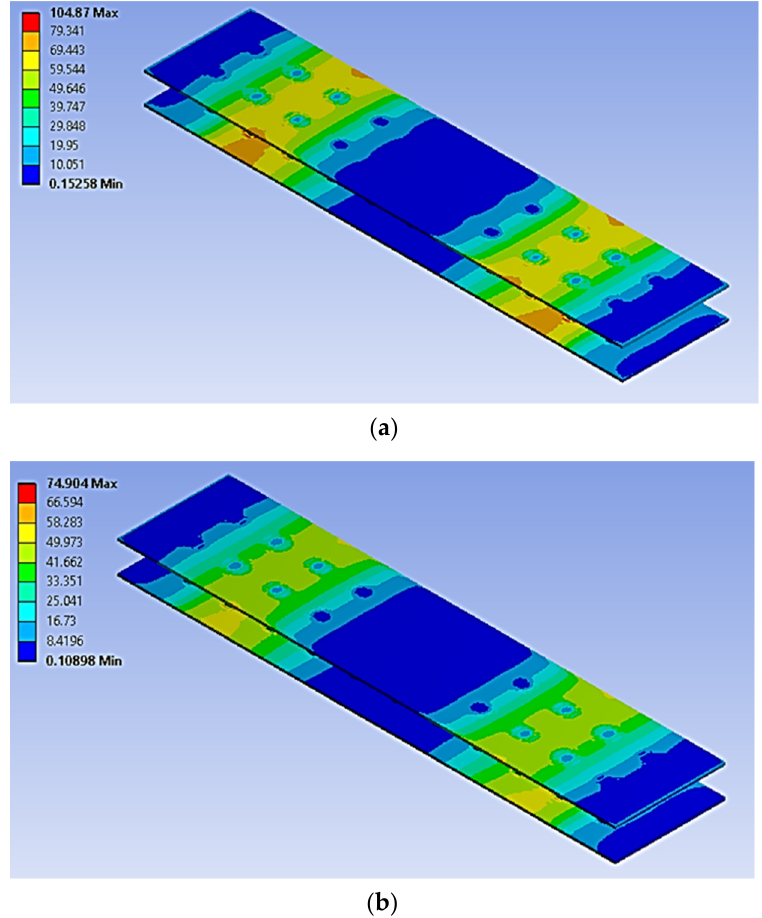
Figure 9. The stress distribution on a simulated panel under cyclic loading conditions (units in MPa): ( a ) 70%, ( b ) 50%.